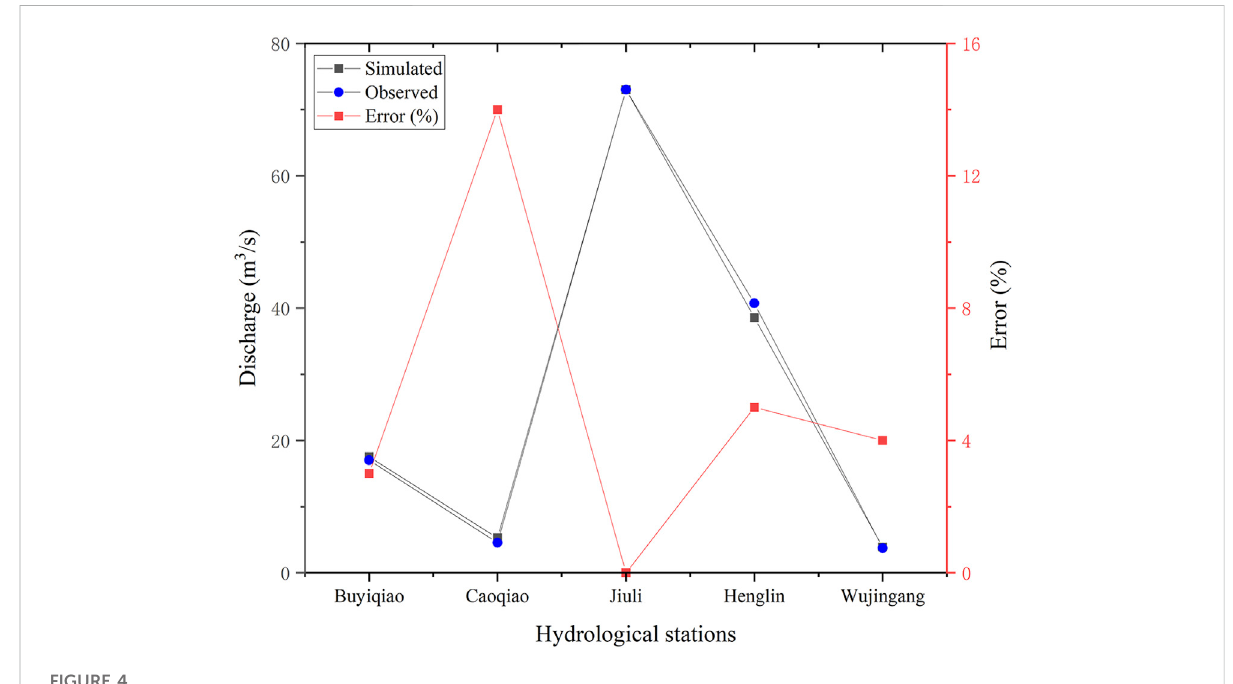
FIGURE 4 Canal discharge simulation and error